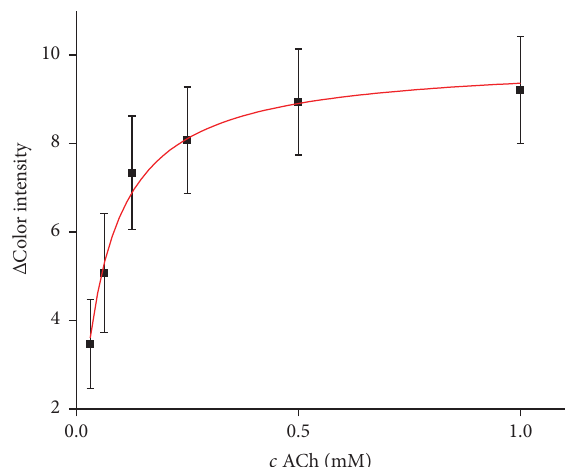
Figure 5: Saturation curve for AChE and AChCl as a substrate. Error bars represent standard error of the mean for 𝑛 = 3.